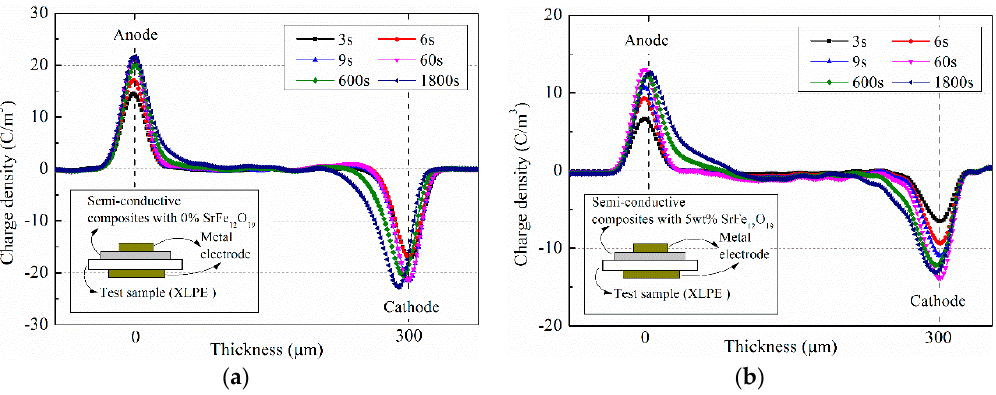
Figure 6. Space charge distribution in insulation sample under the action of semi-conductive composites with different SrFe 12 O 19 contents ( a ) 0%; ( b ) 5 wt.%.